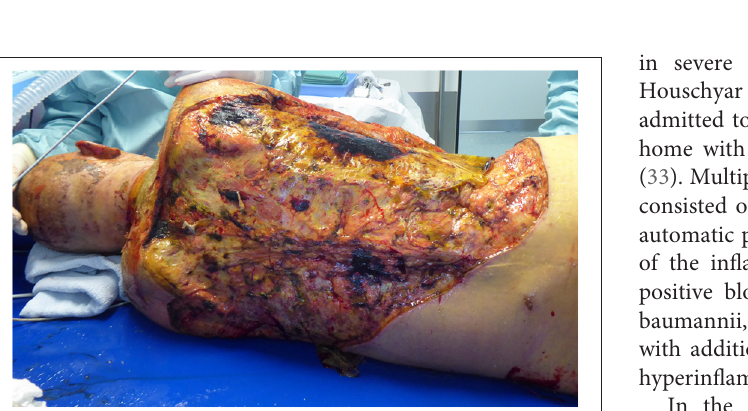
FIGURE 3 | Serious wound complication of the back after removal of xenograft due to infection with MRSA and Candida albicans in an icteric